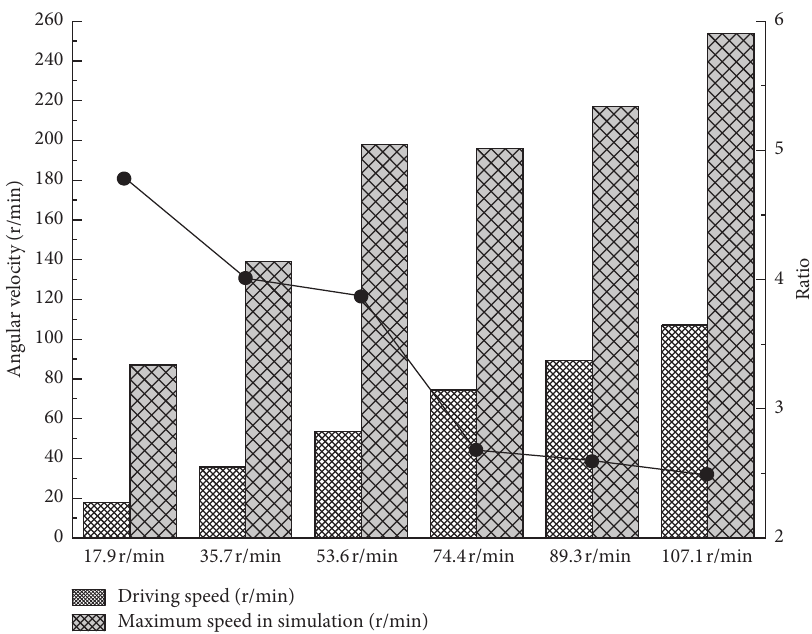
Figure 7: Driving velocity and the maximal angular velocity of numerical